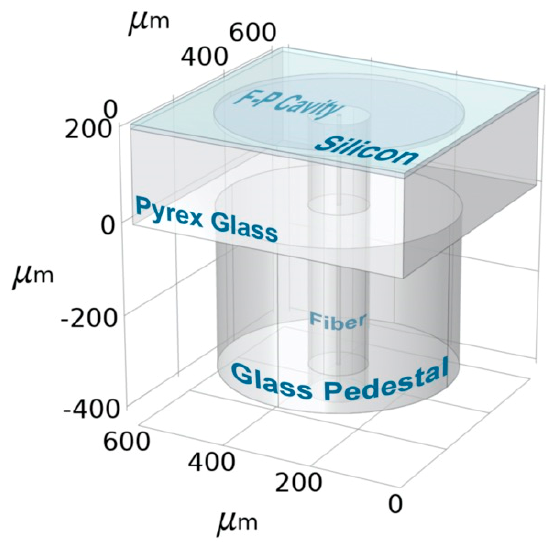
Figure 1. Schematic diagram of sensor diaphragm.